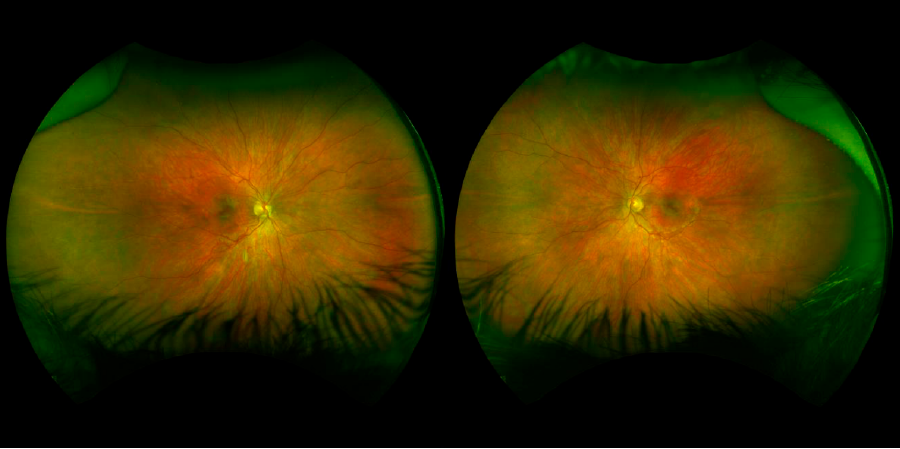
Figure 3. Fundus photos of Patient III-6. Fundus photos showing a tilted, myopic-appearing optic nerves and a myopic-appearing fundus.